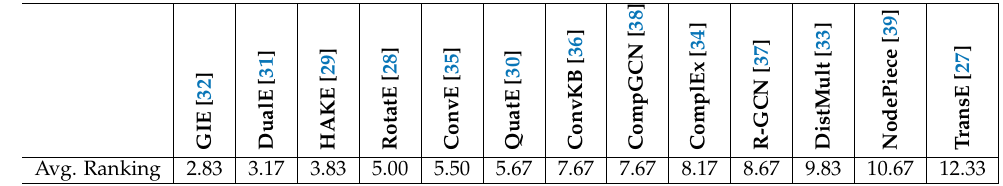
Table 11. Average dataset-specific ranking of each